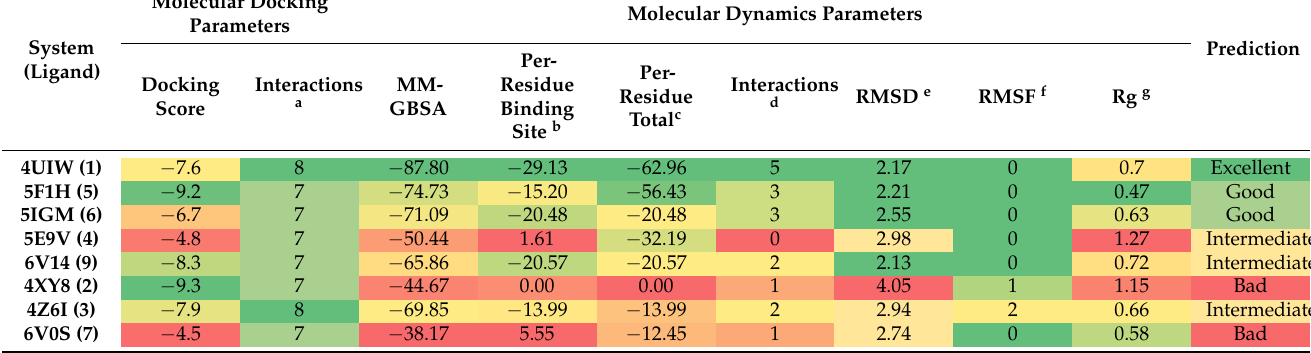
a Number of interactions made with binding site residues. b Calculated considering only the energetic contribution of residues with values below − 5.0 kcal/mol. c Calculated considering only the energetic contribution of binding site residues with values below − 5.0 kcal/mol. d Number of binding site residues with an interaction time fraction above 0.5. e Calculated according to the average RMSD value of the apo form (2.79 Å). f Number of residues belonging to the binding site with a fluctuation above 4.0 Å. g Width of the distribution curve ( apo form width: 0.72